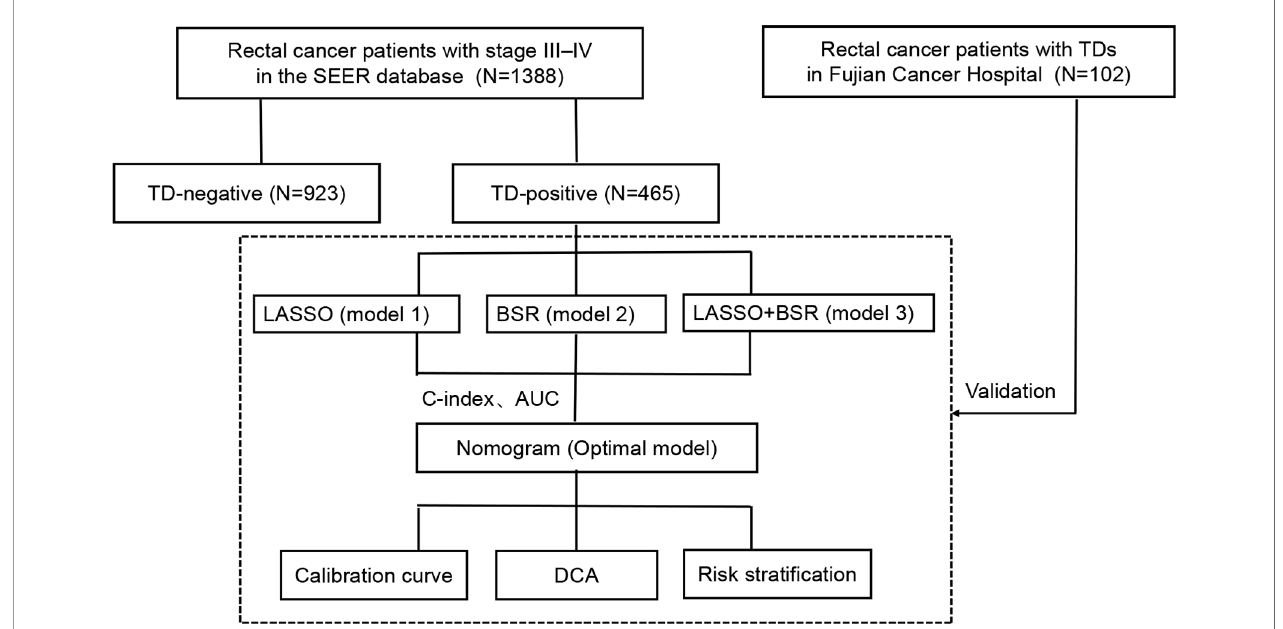
FIGURE 1 | Flowchart of the study design. SEER, Surveillance, Epidemiology, and End Results; TD, tumor deposit; LASSO, least absolute shrinkage and selection operator regression; BSR, backward stepwise regression; C-index, concordance index; AUC, area under the curve; DCA, decision curve